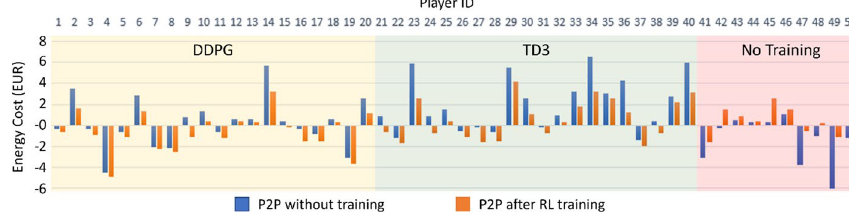
Fig. 9 Comparison of the energy costs during a week before and after the RL training, for both RL algorithms and the agents without